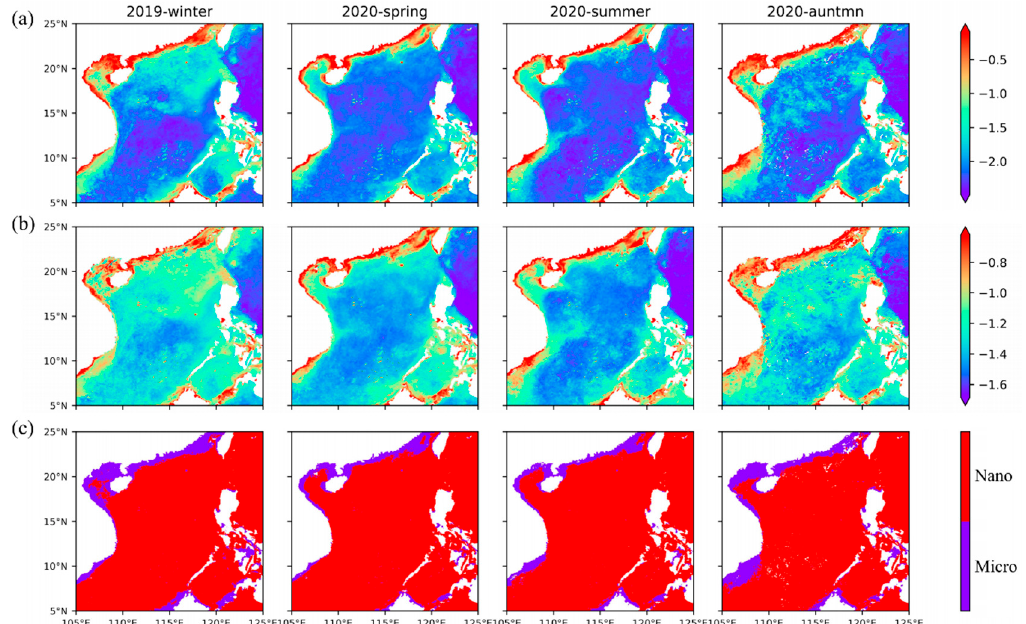
Figure 8. The distribution of Micro and Nano in the SCS: seasonal average abundance distribution of microphytoplankton ( a ) and nanophytoplankton ( b ), and the distribution map of the dominant sizes ( c ). Nano and Micro indicate the nanophytoplankton and microphytoplankton, respectively.